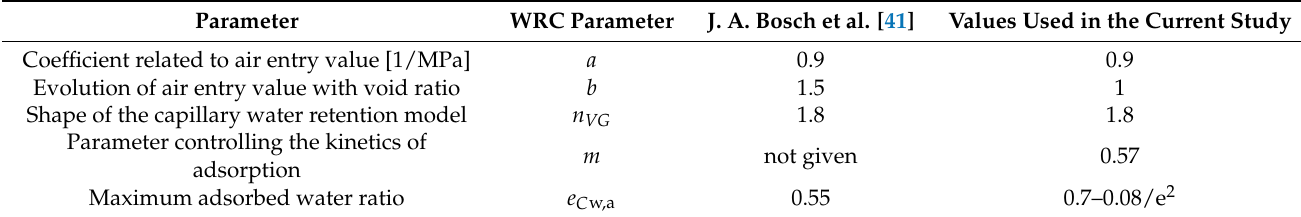
Table 1. Parameters for the WRC model.